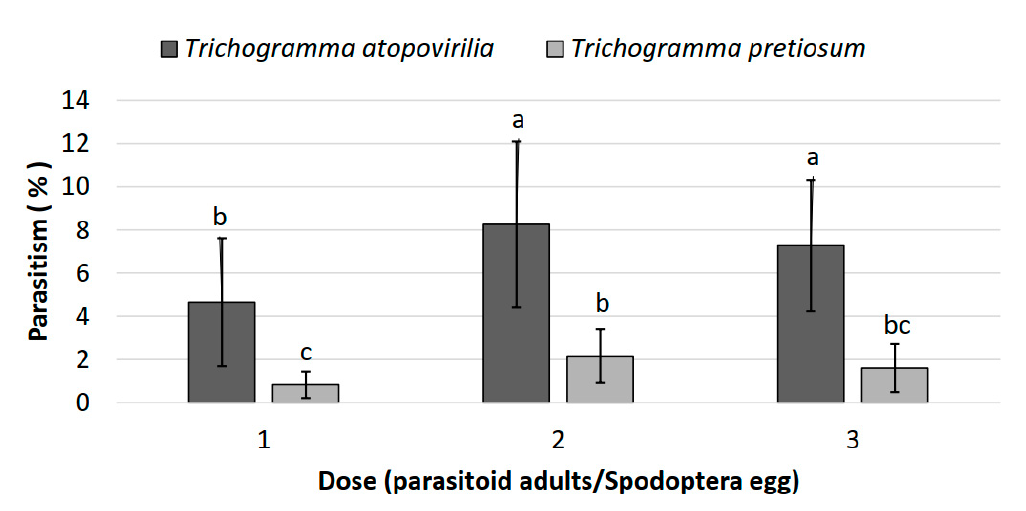
Figure 2. Parasitism in field cages by T. atopovirilia and T. pretiosum on Spodoptera frugiperda eggs. Same letter above the columns indicates non-significant differences between treatments.